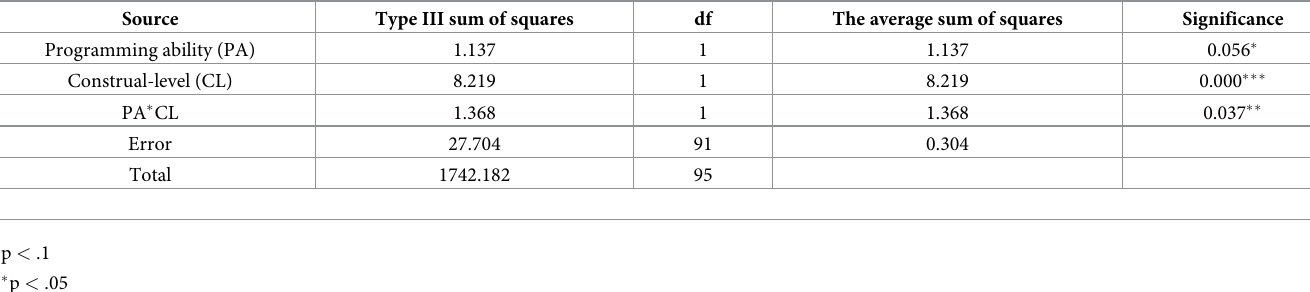
Table 2. Summary of the two-way ANOVA to investigate the interrelationships between PA, CL, and LS.